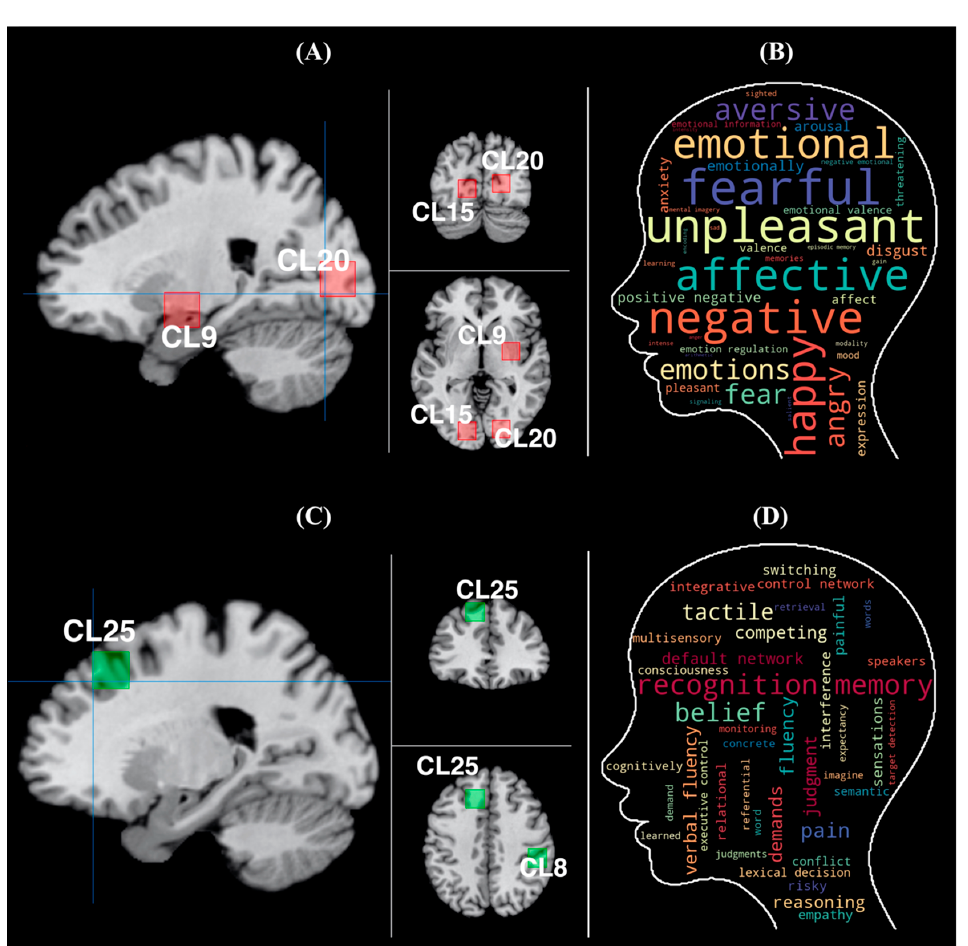
Figure 7. ROI of watershed brain regions and result of decoding study. ( A ) The watershed brain regions for distinguishing branded objects with brand equity and unbranded objects without brand equity; red squares represent ROIs, crosshairs = (22, − 79, − 3); left = sagittal view; top right = coronal view; lower right = axial view. The brain region of centroid in CL9 is the PHG; the brain region of centroid in CL15 and 20 is the LG. ( B ) The result of decoding study in branded objects via the cognitive decoding function in Neurosynth. ( C ) Clusters with influences on mental processes of unbranded objects; green squires represent ROIs, crosshairs = ( − 21, 34, 40); left = sagittal view; top right = coronal view; lower right = axial view. The brain region of centroid in CL8 is the IPL (BA40). The brain region of centroid in CL25 is the SFG (BA8, DLPFC). ( D ) The result of the decoding study in unbranded objects via the cognitive decoding function in Neurosynth. Abbreviations: ROI: region of interest; CL: cluster; PHG: parahippocampal gyrus; LG: lingual gyrus; IPL: inferior parietal lobule; SFG: superior frontal gyrus; DLPFC: dorsolateral prefrontal cortex.